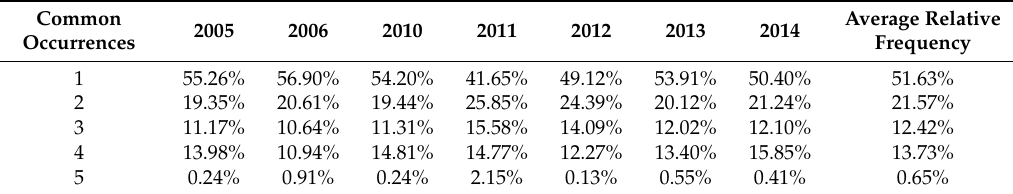
Table 6 . Comparison of distribution of precooling days.